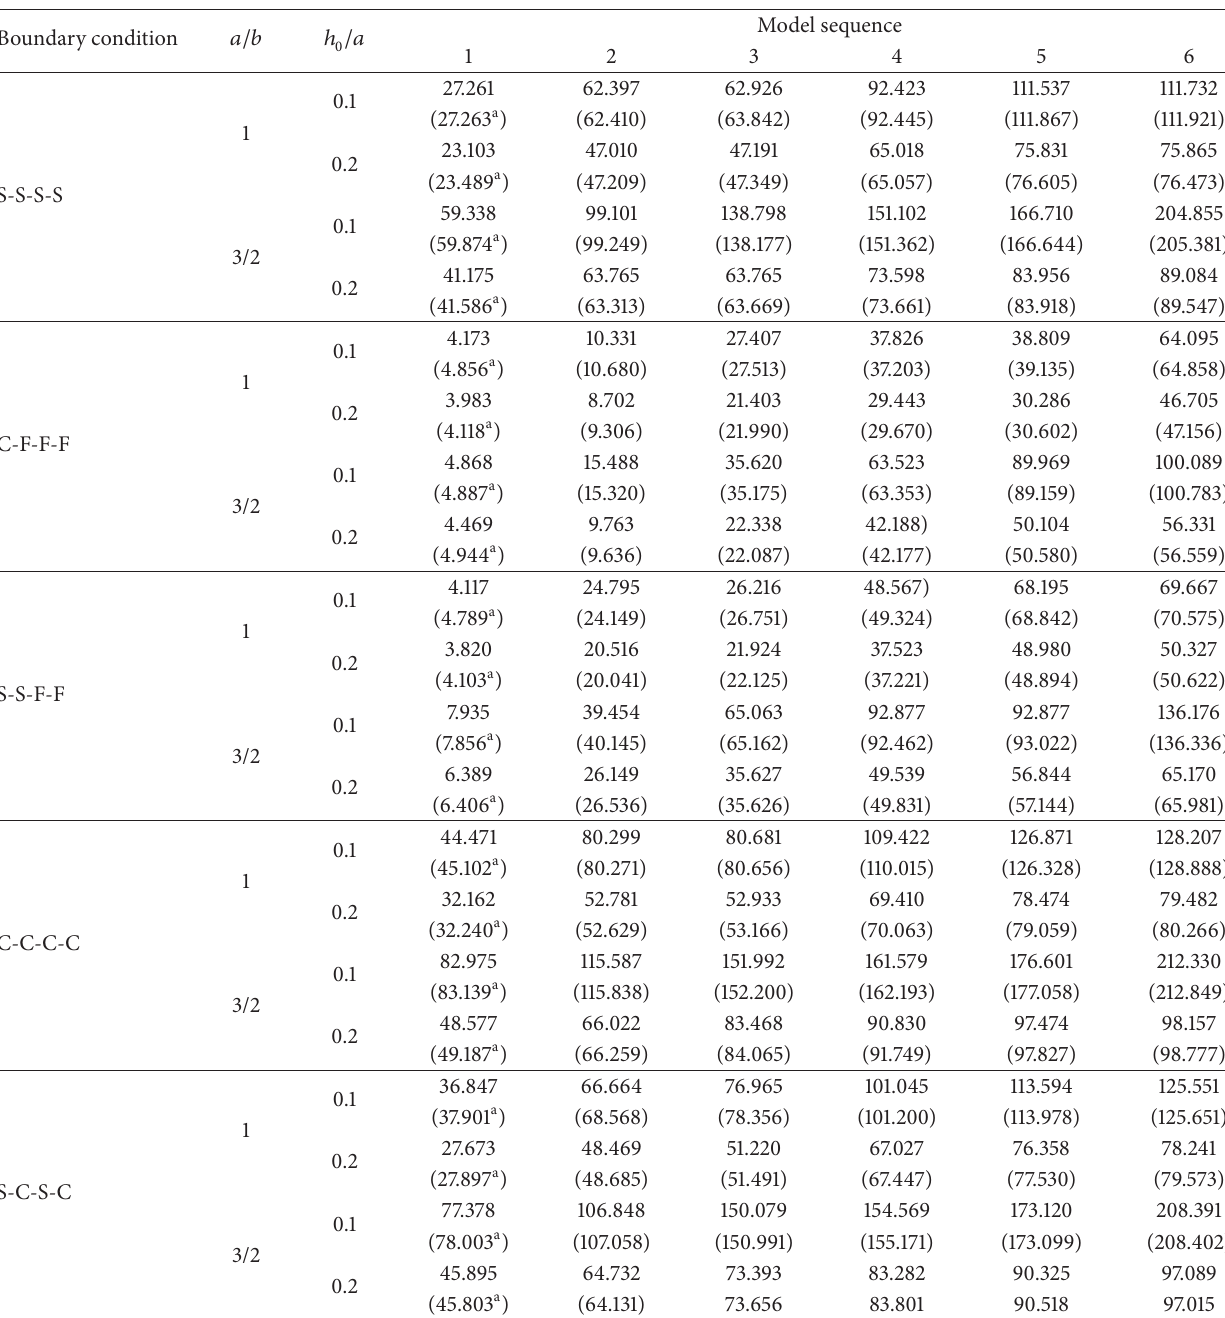
Table 5: Frequency parameter Ω = 𝜔𝑎 2 (𝜌ℎ 0 /𝐷 0 ) 1/2 for moderately thick plates with linearly varying thickness in different boundary conditions ( ℎ(𝑥,𝑦) = ℎ 0 (1 + 0.5𝑥)(1 + 0.5𝑦)